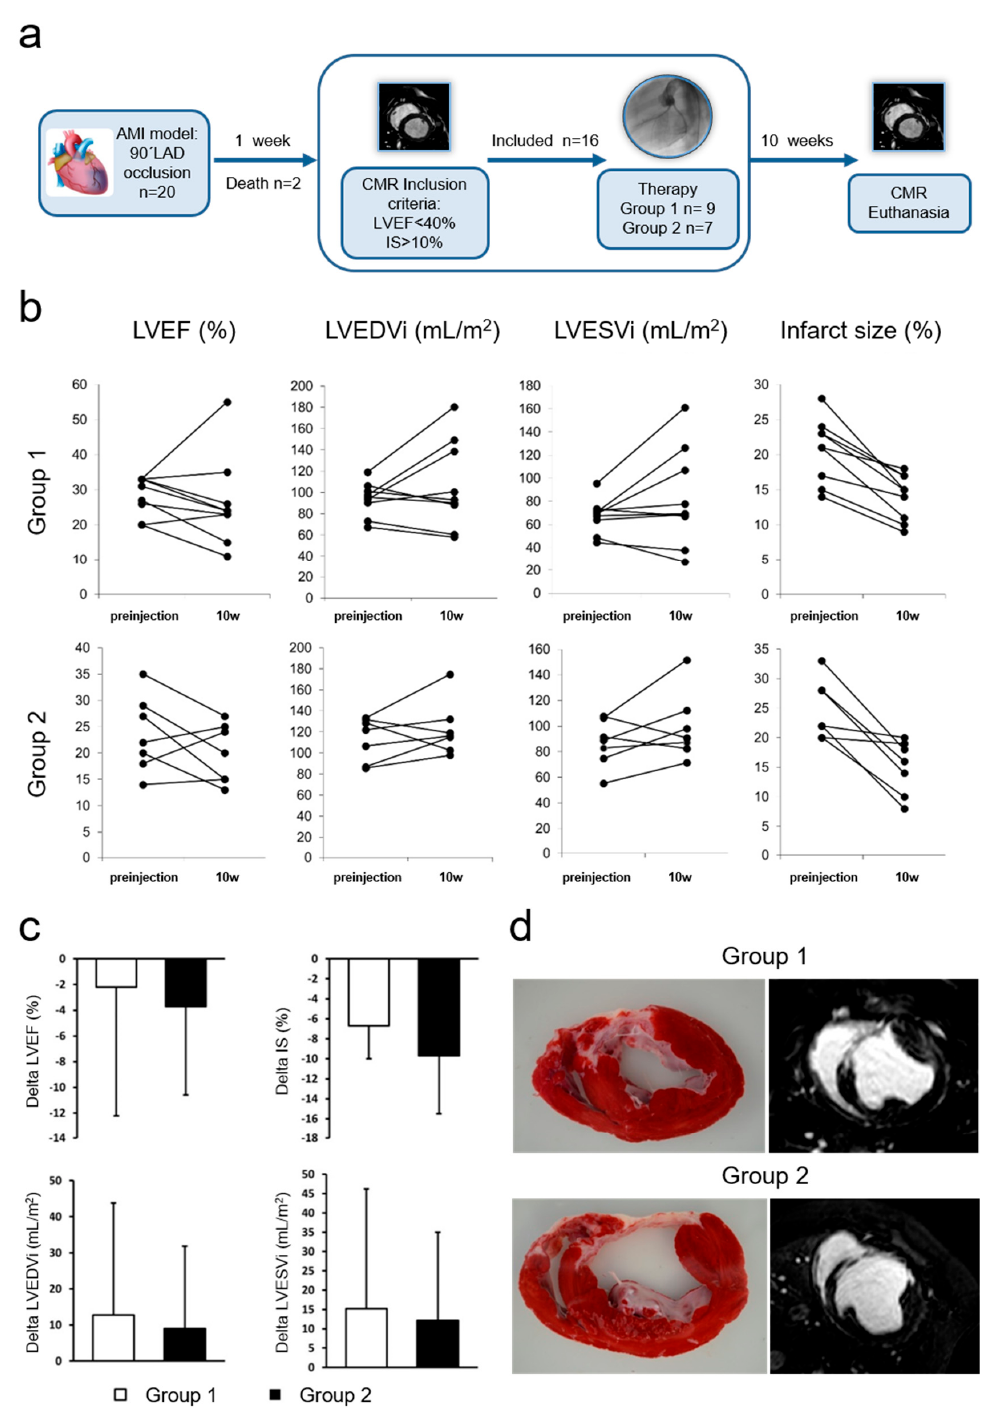
Figure 6. In vivo study in infarcted swine. ( a ) Study design. Experimental workflow illustrating porcine studies. ( b ) Paired data scatterplots showing changes over time in cardiac function parameters as measured with cardiac magnetic resonance (CMR) for the two experimental groups. From left to right, left ventricular ejection fraction (LVEF), left ventricular end diastolic volume indexed to body surface area (LVEDVi), left ventricular end systolic volume indexed to body surface area (LVESVi), and infarct size (IS) in Group 1 (top tier) and Group 2 (lower tier). Group 1 (treatment) = injection of pCPC-HGF-mCherry + pCPC-IGF1-eGFP; Group 2 (control) = injection of pCPC-mCherry + pCPC-eGFP. ( c ) Treatment effects (defined as the difference between pre-injection and 10 − week values) from the same parameters. ( d ) Representative CMR and TTC − stained slices from the two studied